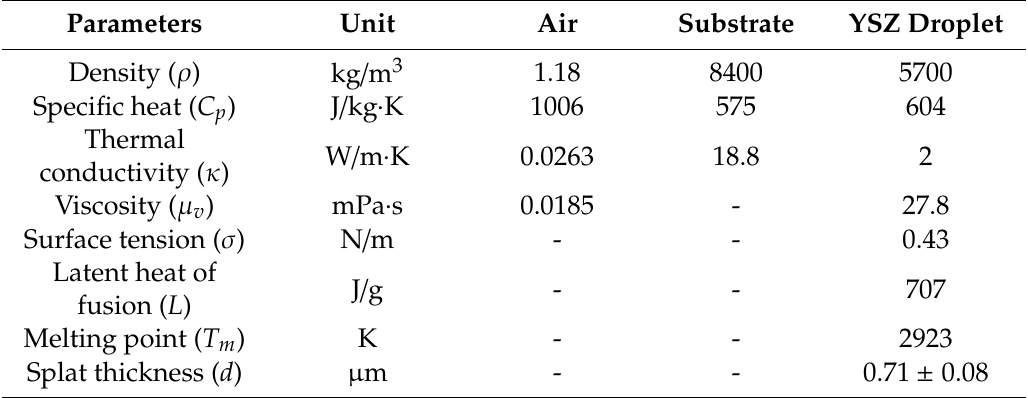
Table 2. Thermophysical parameters of di ff erent materials used in simulations [13,32].